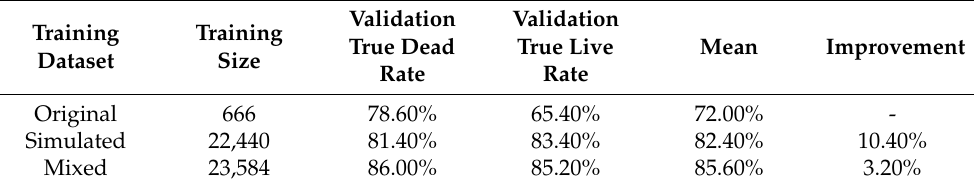
Table 8. Comparison of model accuracy when trained with different datasets and validated with the original validation set.